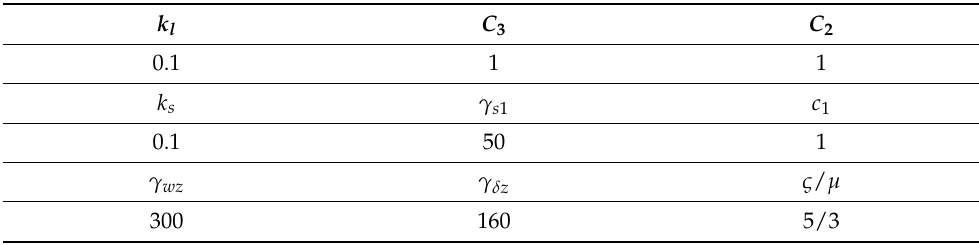
Table 1. Parameters of